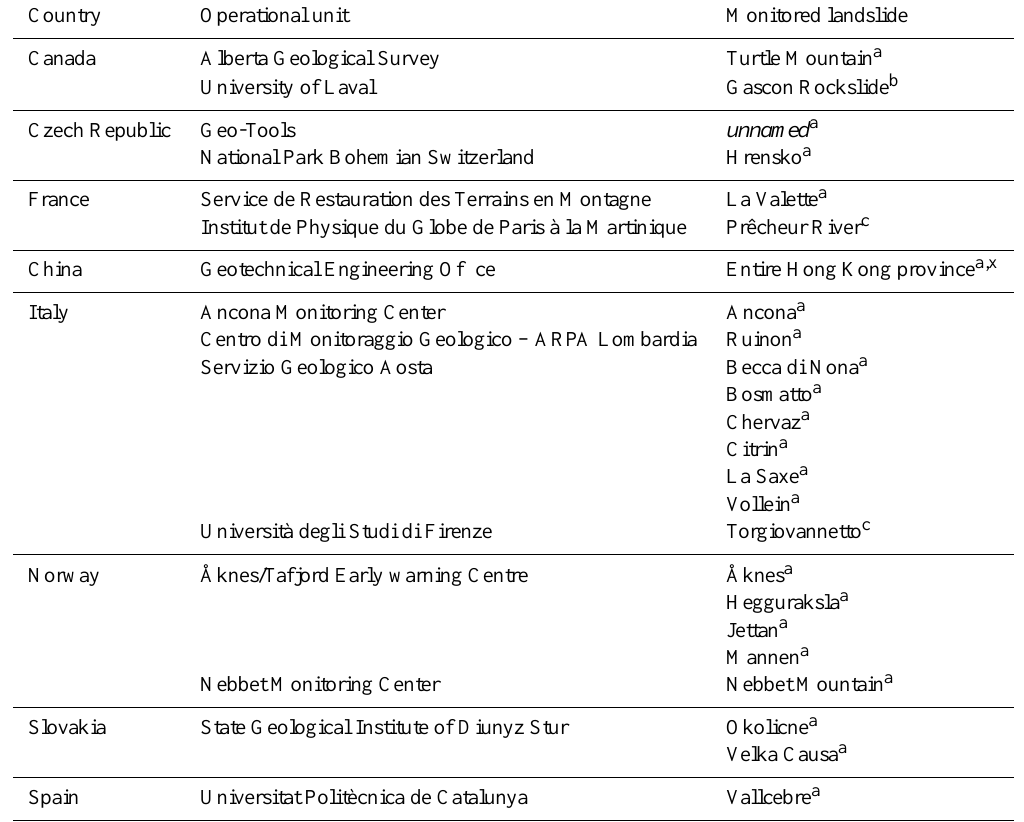
Table 1. Exhaustive list of the monitored landslides and their related operational units that answered the questionnaire during summer 2011. Country